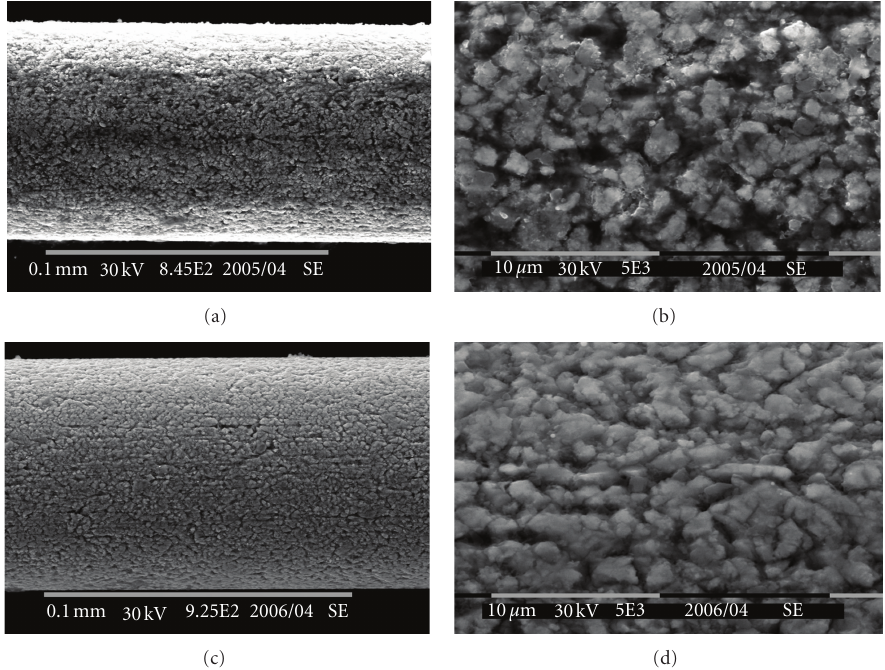
Figure 6: SEM images of the NiTi wire of diameter 90 μ m before (a), (b) and after (c), (d) high-dose ion implantation with Ti ions of fluence D = 2 × 10 17 cm − 2 at an average accelerating voltage of 60 kV and pulse repetition frequency of 50 Hz.